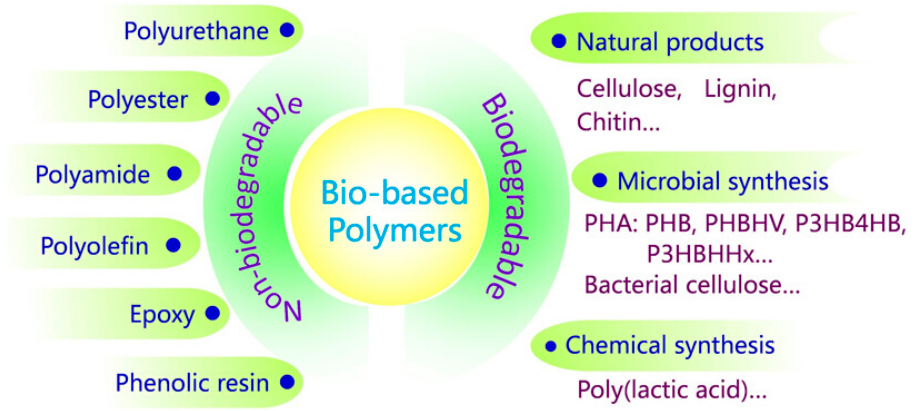
Figure 1. Classification of bio-based polymers.